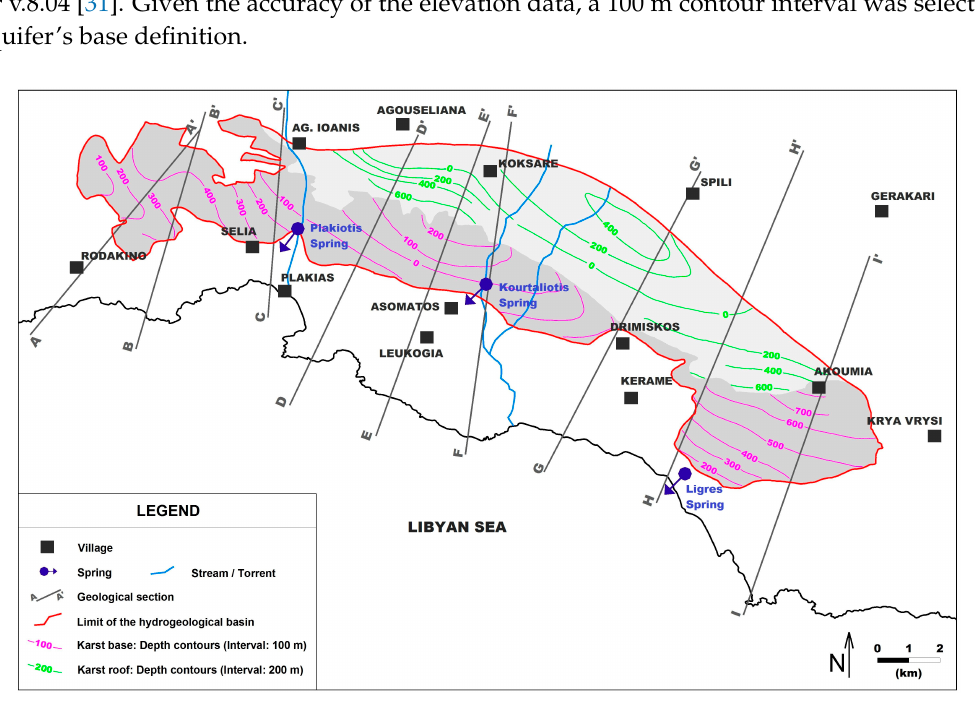
Figure 4. Structure contours drawn to represent the base and the top of the hydrogeological unit.